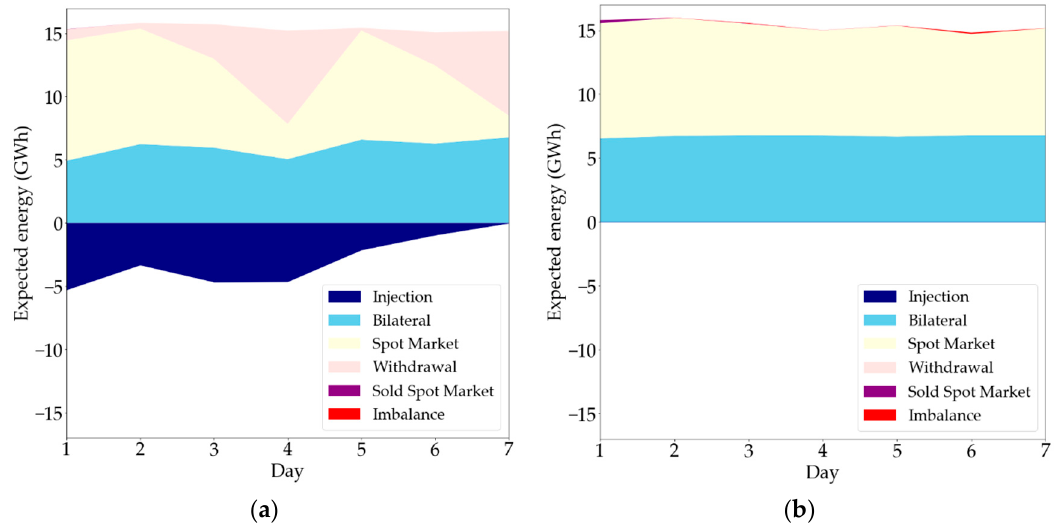
Figure 15. The expected gas procurement. ( a ) Natural used per day to feed the combined-cycle gas turbine (CCGT) using the gas storage; ( b ) natural used per day to feed the CCGT without gas storage.